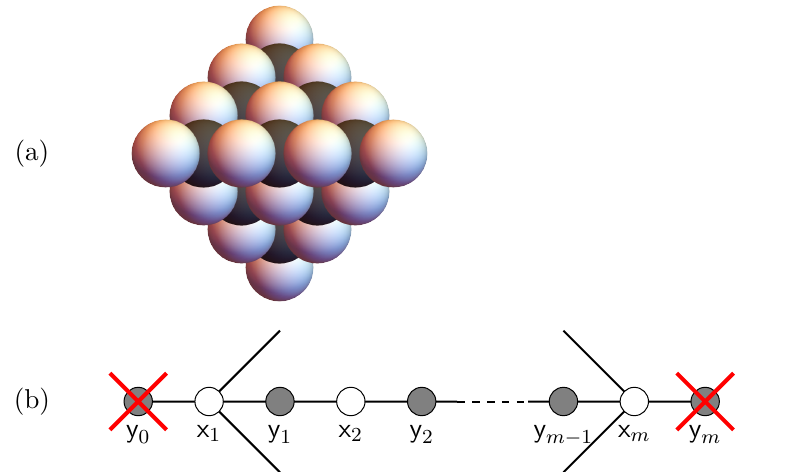
with k = 1 , 2 , . . . , m − 1 , and k